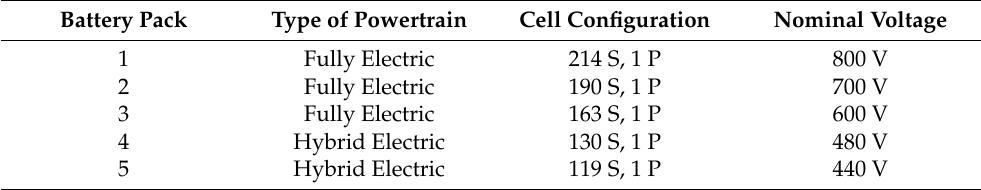
Table 2. Selected battery pack